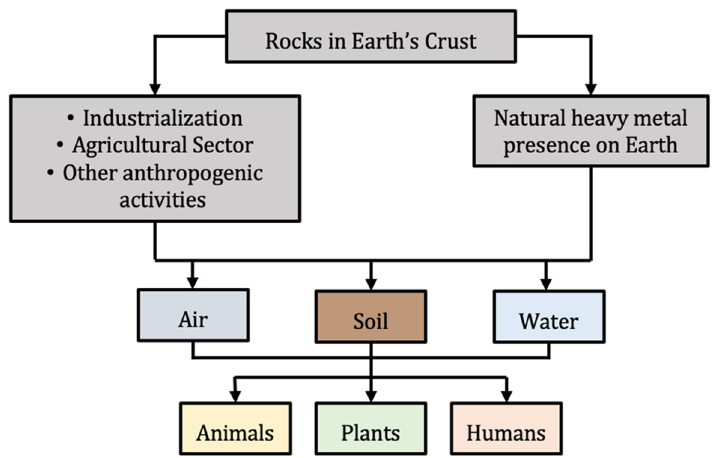
Figure 1. The heavy metal sources and their pathway into the environment and humans. Table 1 represents the possible sources that might contribute to the increment of certain heavy metal ions in the water bodies, with respective harmful effect to humans and the permissible limit for each metal in order to be classified as safe water [16]. Table 1. Several heavy metal ions, with its respective possible source, health hazard and WHO (World Health Organization) permissible limit for water drinking. Adopted from reference [16] (copyright reserved Elsevier, 2020). Metal